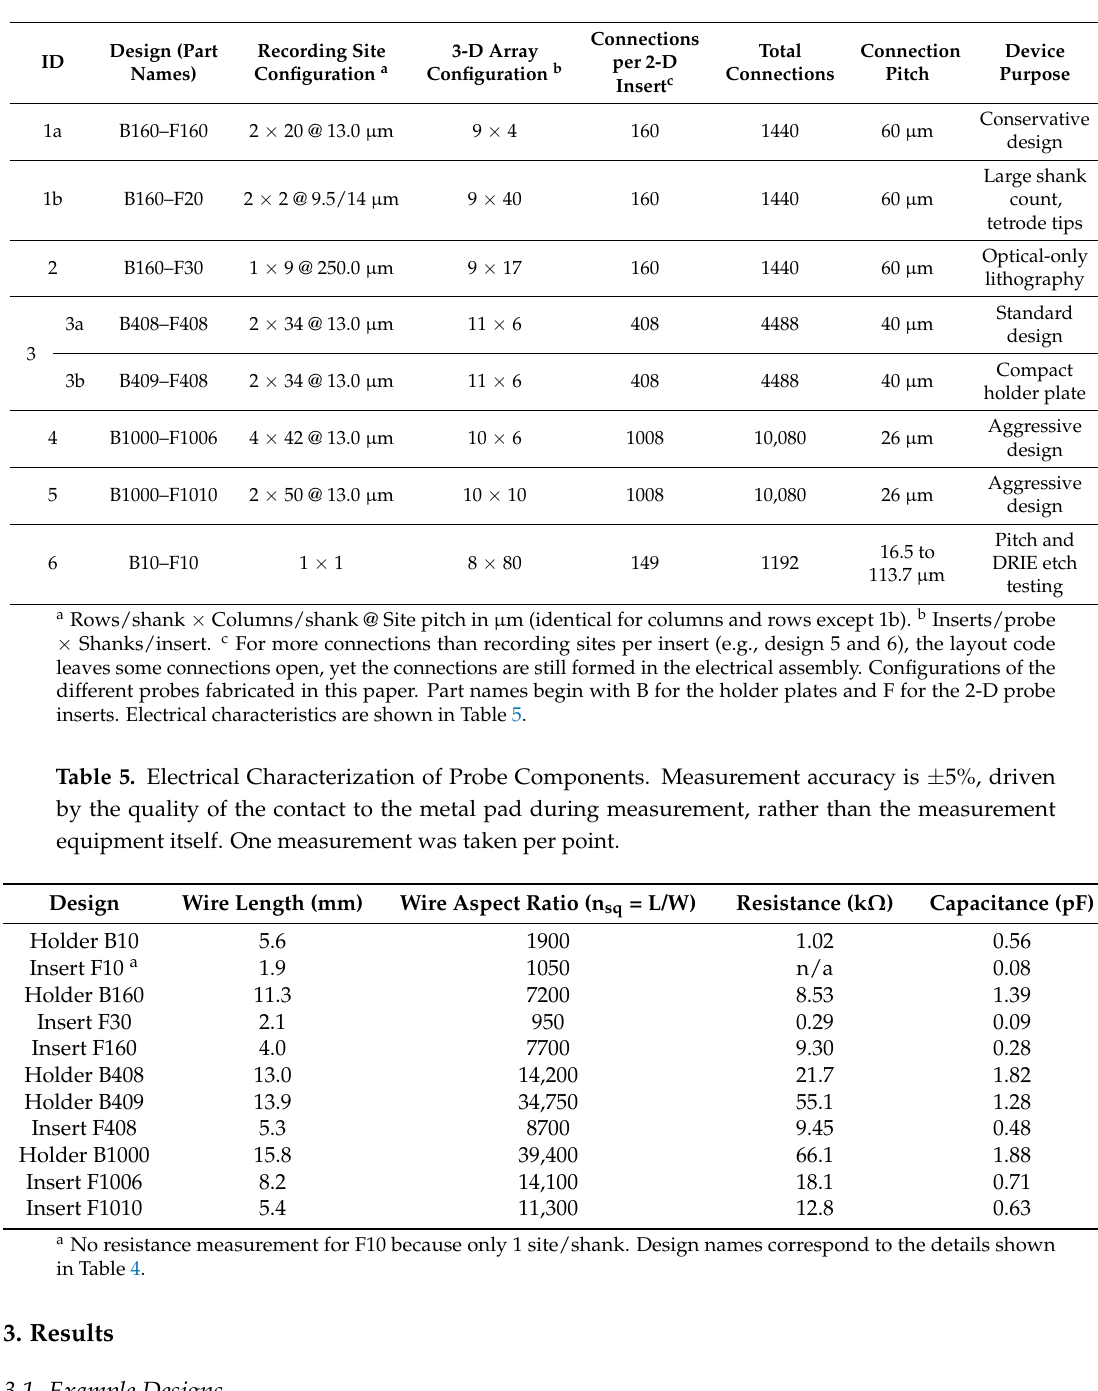
Table 4. Design summary of example designs in this paper.